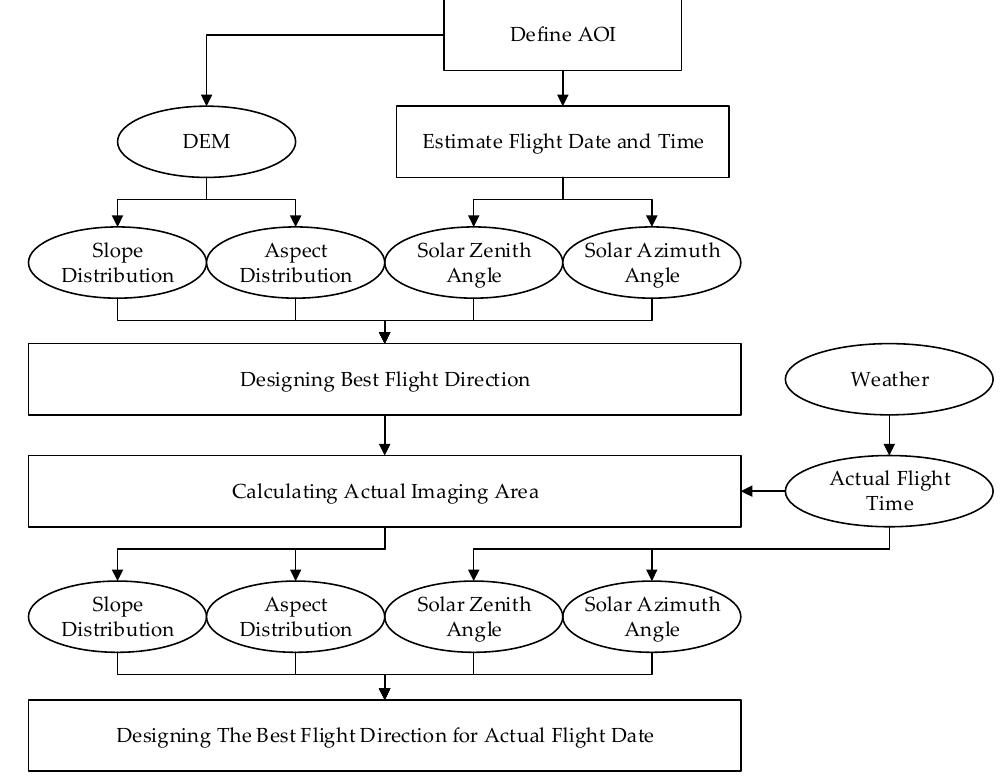
Figure 15. the workflow of the optimized flight direction design method. Figure 16. The workflow of the optimized flight direction design